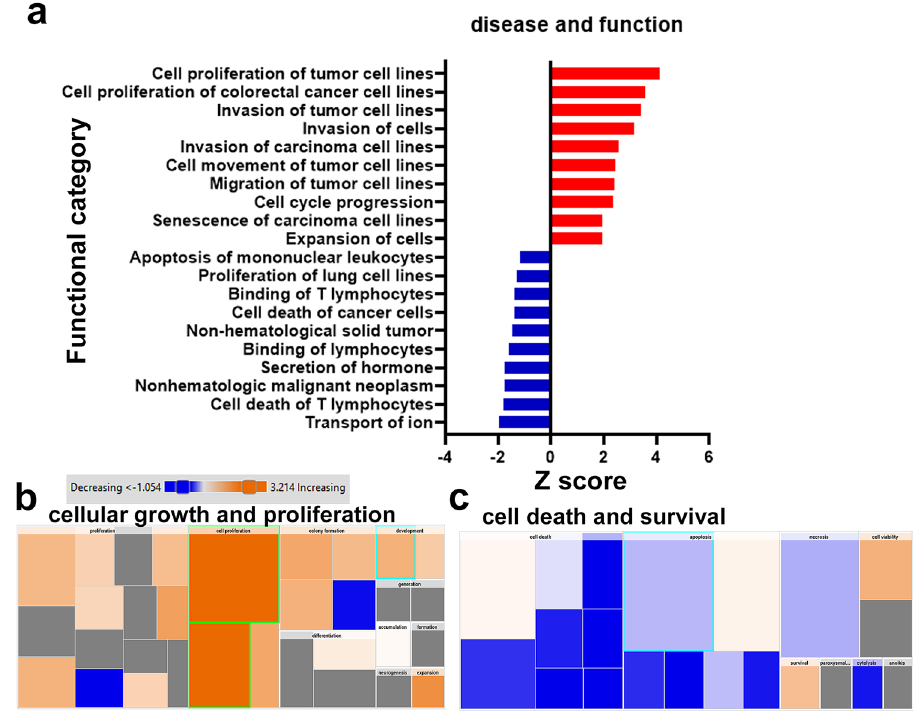
Figure 3. Functional category annotation analysis highlights activation of cell proliferation and migration as the hallmark of CRC. (a) Disease and function analysis of differentially expressed mRNAs in CRC. Y-axis indicated the functional category and the x-axis represent the activation Z score. Heatmap representation of cellular growth and proliferation (b) and cell death and survival (c) functional categories. Activation Z score is depicted according to the color